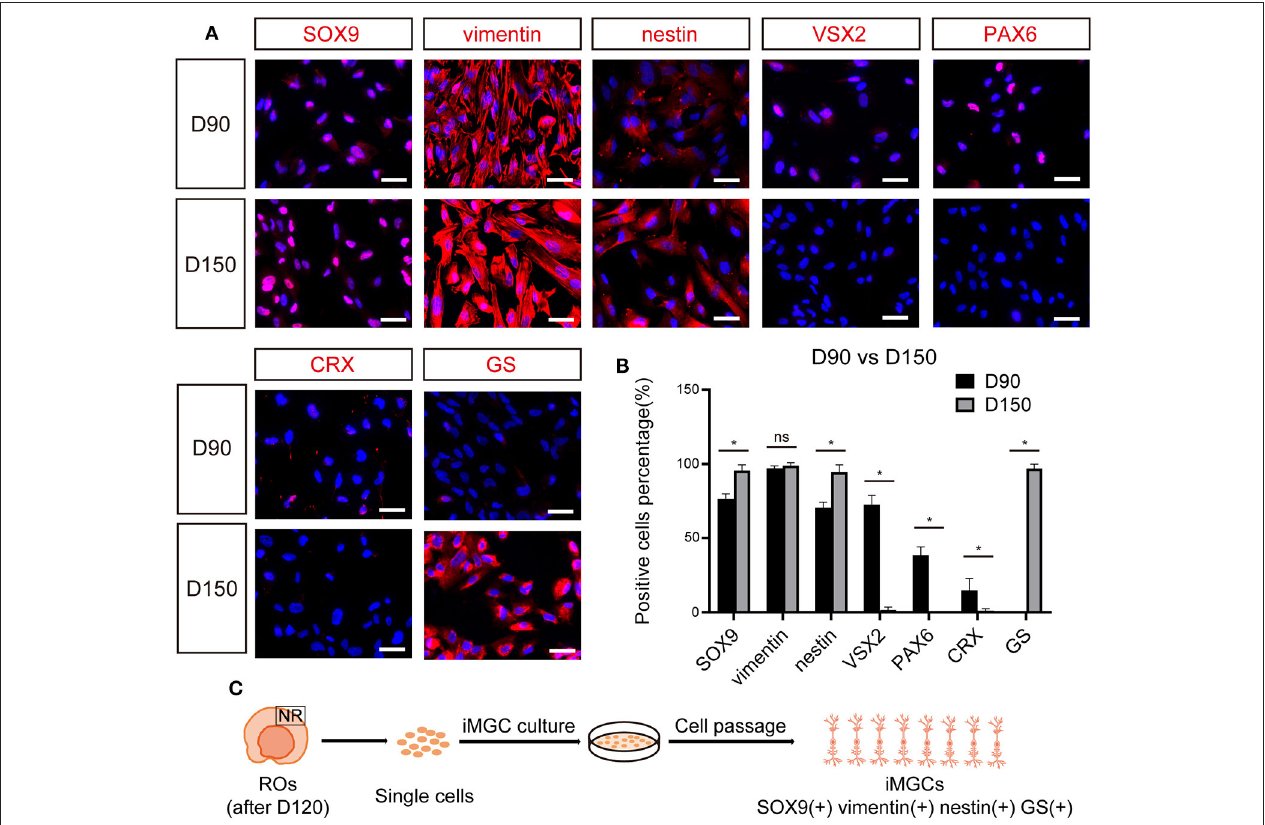
FIGURE 4 | The expression of cell-specific markers in passaged iMGCs from early- and late- stage ROs. (A) Immunofluorescence staining showed the expression of markers SOX9, vimentin, nestin, VSX2, PAX6, CRX, and GS in the passaged cells isolated from D90- and D150-ROs. (B) Percentage of positive cells in (A) . Cell number > 100, * p < 0.05. (C) Schematic diagram of molecular characteristics of iMGCs isolated from the late-stage ROs. ROs, retinal organoids; ns, no significance; Scale bars = 50 µ m (A)